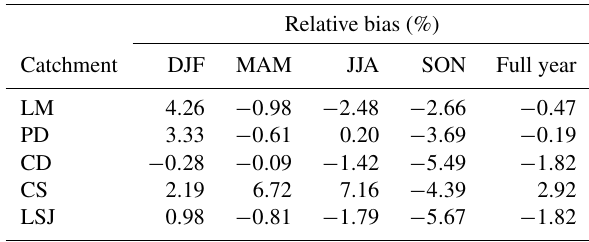
Table 3. Relative bias between the forecast mean and observed 120d inflow volumes and classified by the season during which the forecast was